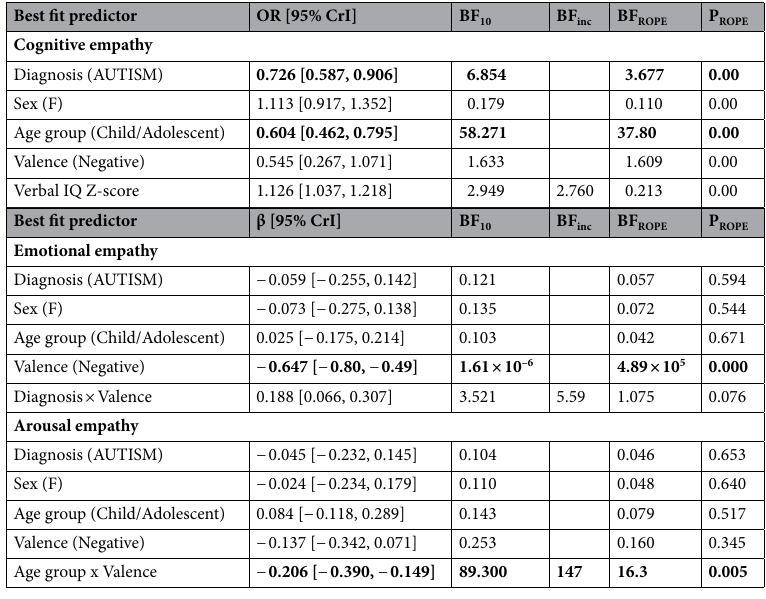
Table 1. Bayesian model analysis results. Practically significant predictors for each empathy component are shown in